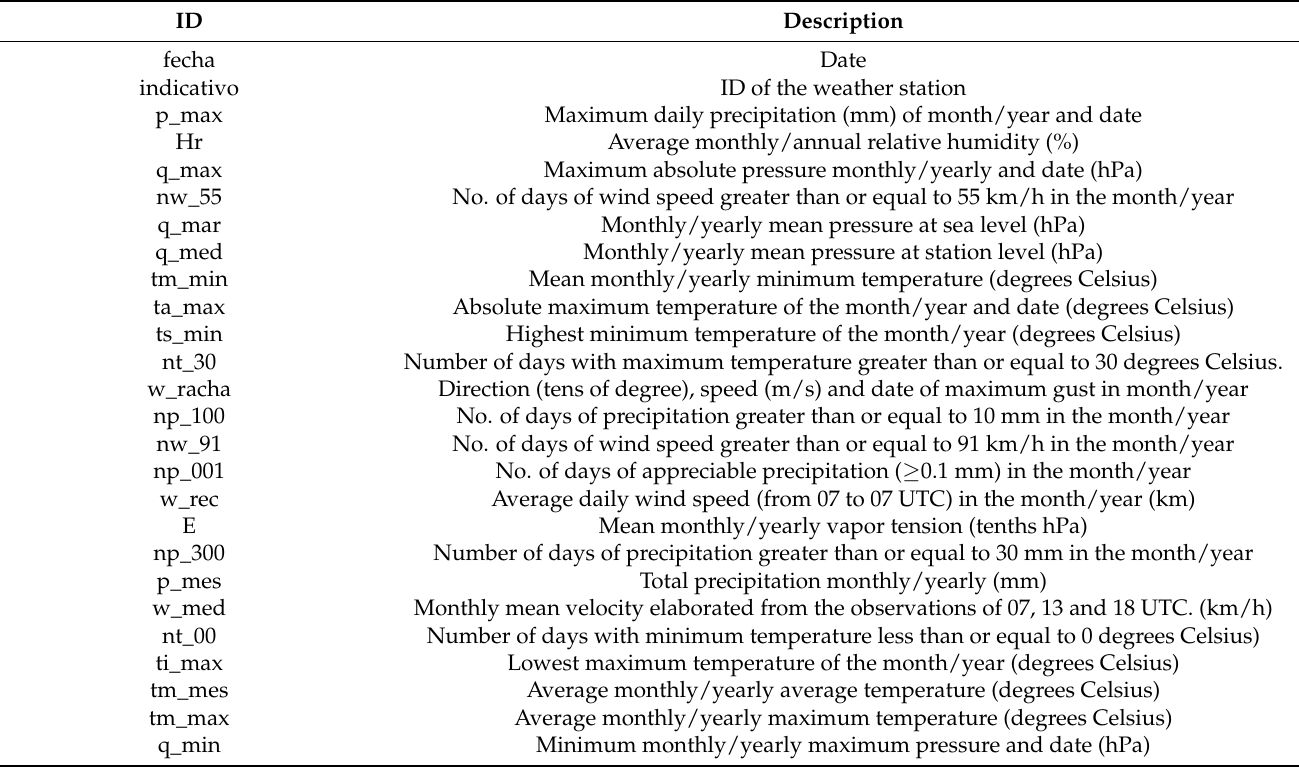
Table 2. Meteorological information included in JSON files downloaded from AEMET OpenData. ID is the name of each variable according to the JSON